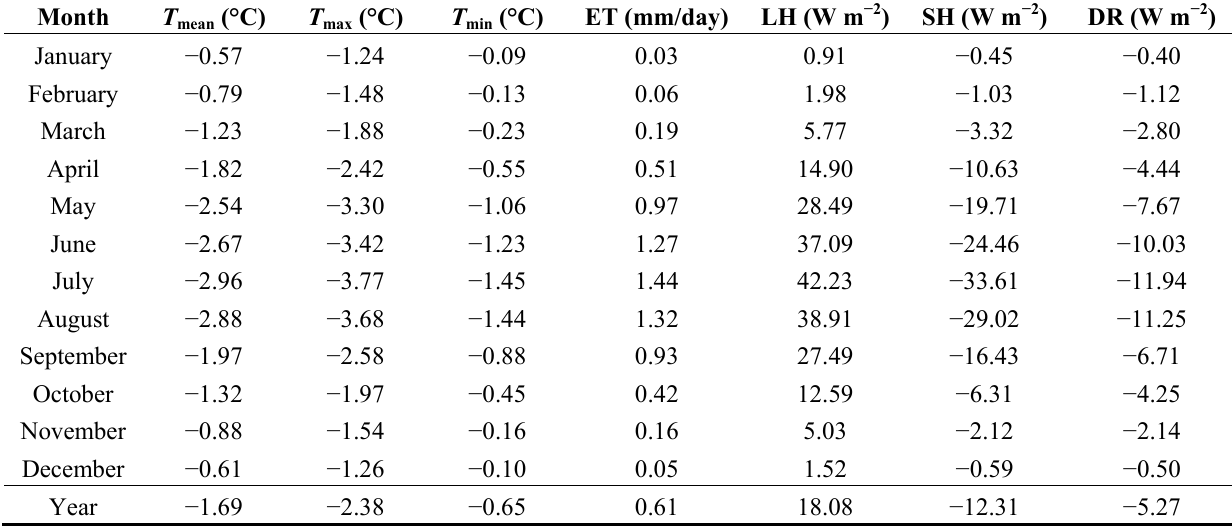
Table 2. Domain-averaged differences for climate variables between CON and